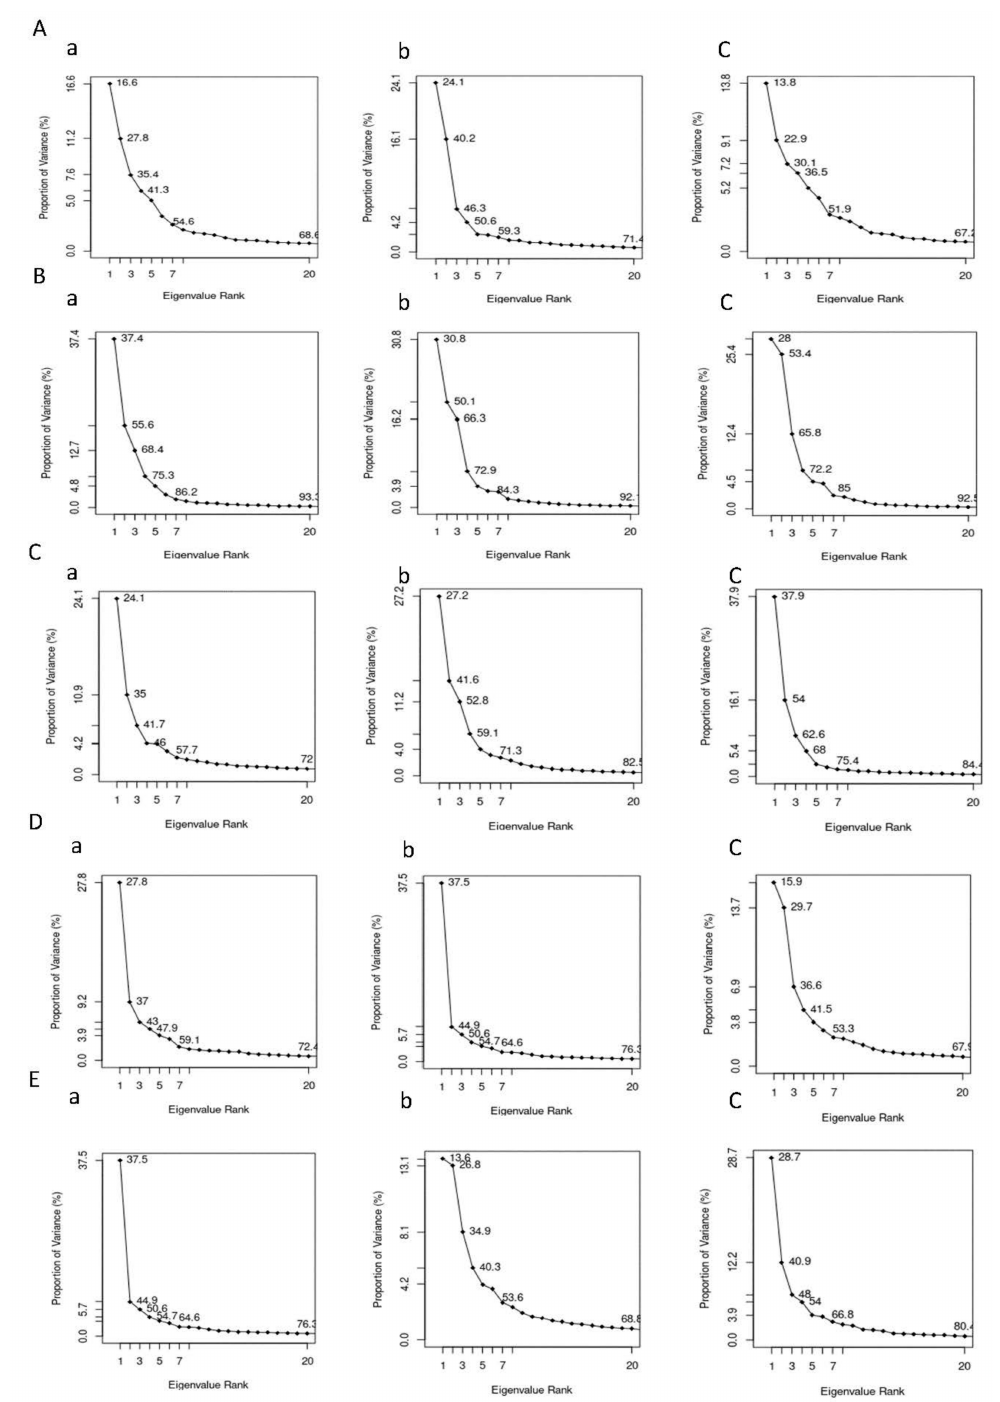
Figure 9. Plot of percentage of variance versus eigenvalue of ( A ) ( a ) AChE-FM, ( b ) AChE-FMS, ( c ) AChE; ( B ) ( a ) AMPK-FN, ( b ) AMPK-FNS, ( c ) AMPK; ( C ) ( a ) ASK1-FM, ( b ) ASK1-FMS, ( c ) ASK1; ( D ) ( a ) GST-IM, ( b ) GST-6-CIPHD, ( c ) GST; and ( E ) ( a )PKC-IM, ( b ) PKC-6-CIPHD, ( c ) PKC. The color of the principal component analysis (PCA) plot change from blue to red as the complex evolves with